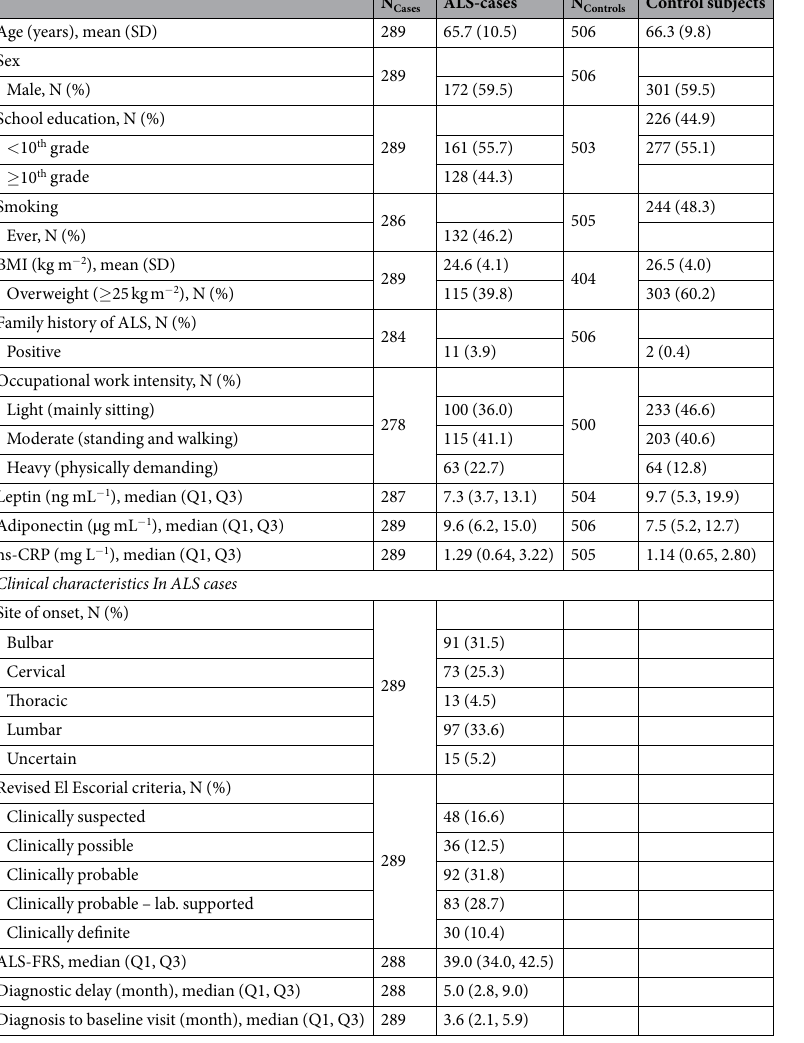
Table 1. Main characteristics of ALS patients and control